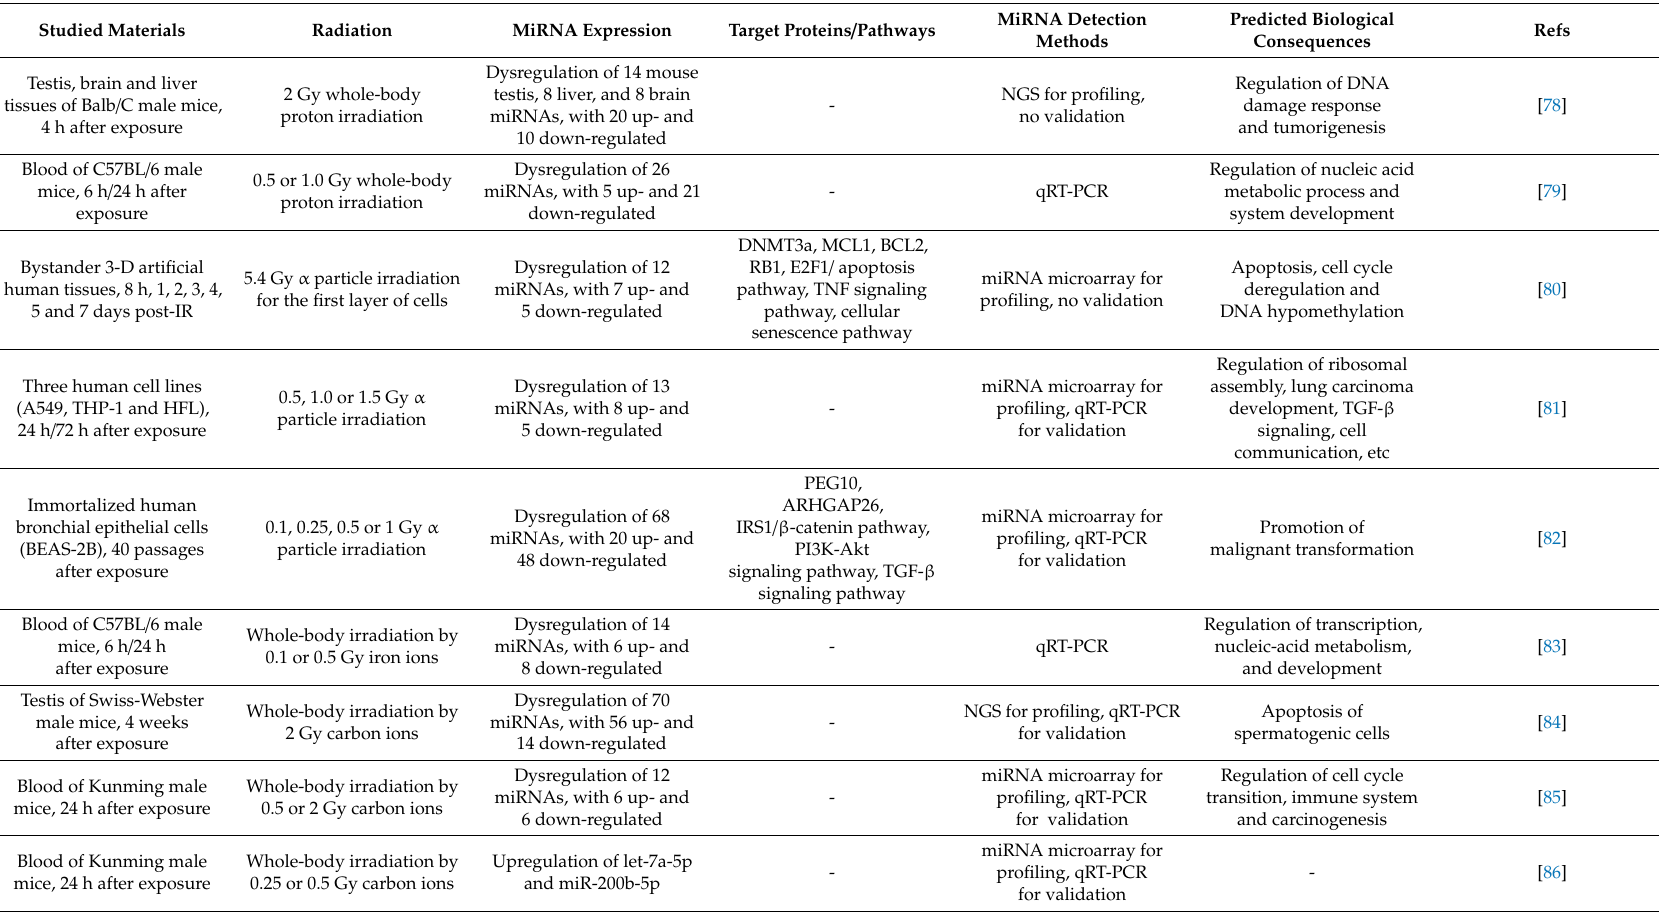
Table 1. Studies relating to miRNAs responding to space